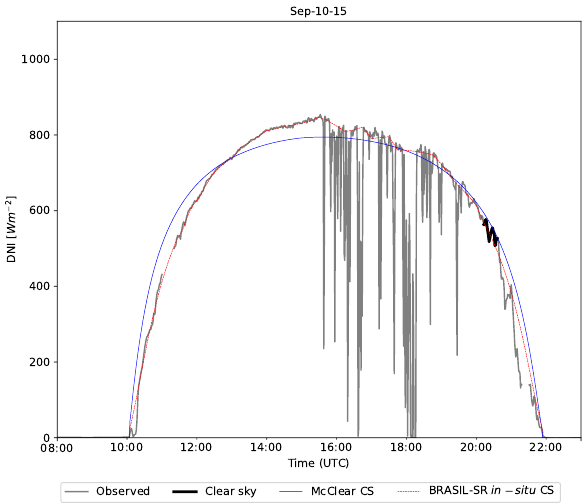
Figure 4. Data flagged as clear-sky by the Bright-Sun algorithm for ARM_Manacapuru on 10 Septem- ber 2015. The clear-sky irradiances from McClear and from BRASIL-SR ( in-situ experiment ) are presented as well for